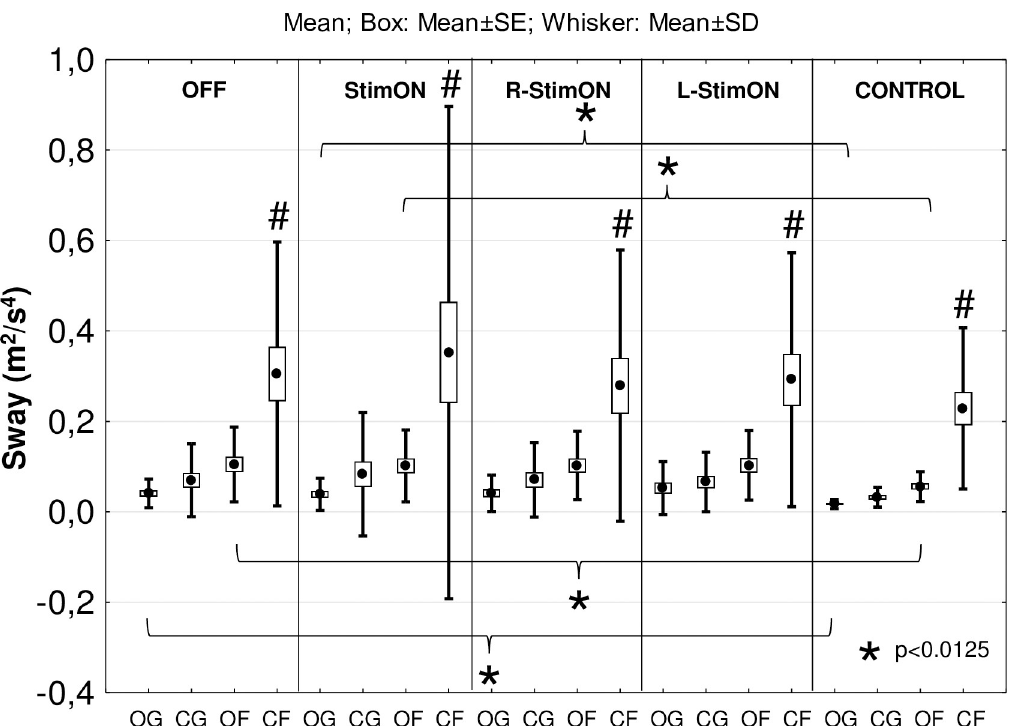
Fig 2. Sway values in the four stimulation conditions and the four tasks. Within the patient and the control group, the sway was significantly larger in the closed eyes-foam task (signed with #) than in the other tasks. The sway in the eyes open-ground and eyes open-foam task was higher in the patient group in OFF and StimON stimulation conditions than in the control group. OG: Eyes open-ground; CG: Eyes closed-ground; OF: Eyes open-foam; CF: Eyes